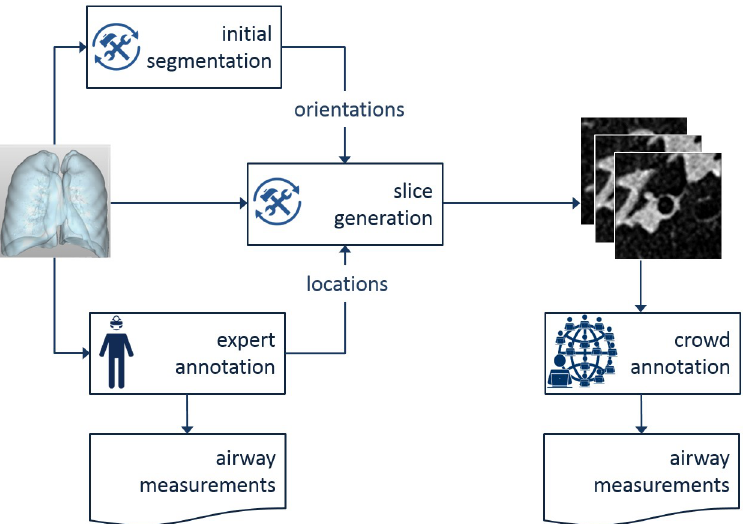
Fig 1. Overview of the method. A 3D image is annotated by experts. The locations and orientations of the airways are then used to generate 2D slices of the airways, which are then annotated by the workers.